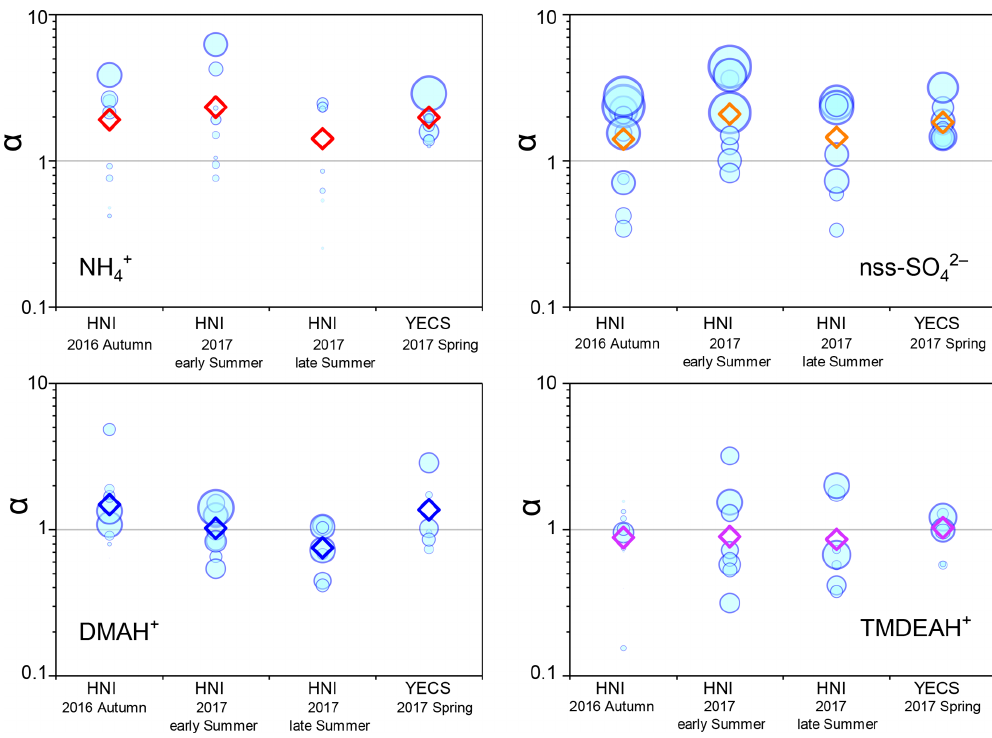
Figure 6. The α values of NH + , nss-SO 2 − and aminiums in different campaigns. The diameter of the circle is proportional to the concen- 4 4 tration and the diamond-shaped symbol represents the average value of α for each campaign. It should be noted that the bottom of column is the line of α =